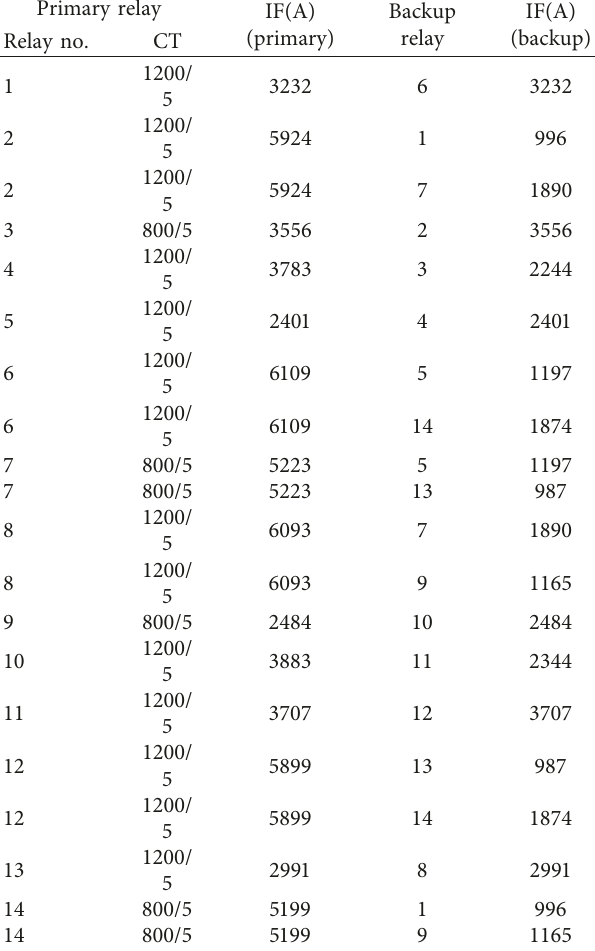
Table 12: P/B pairs and related parameters for the 8-bus system with MINLP formulation [3, 16].